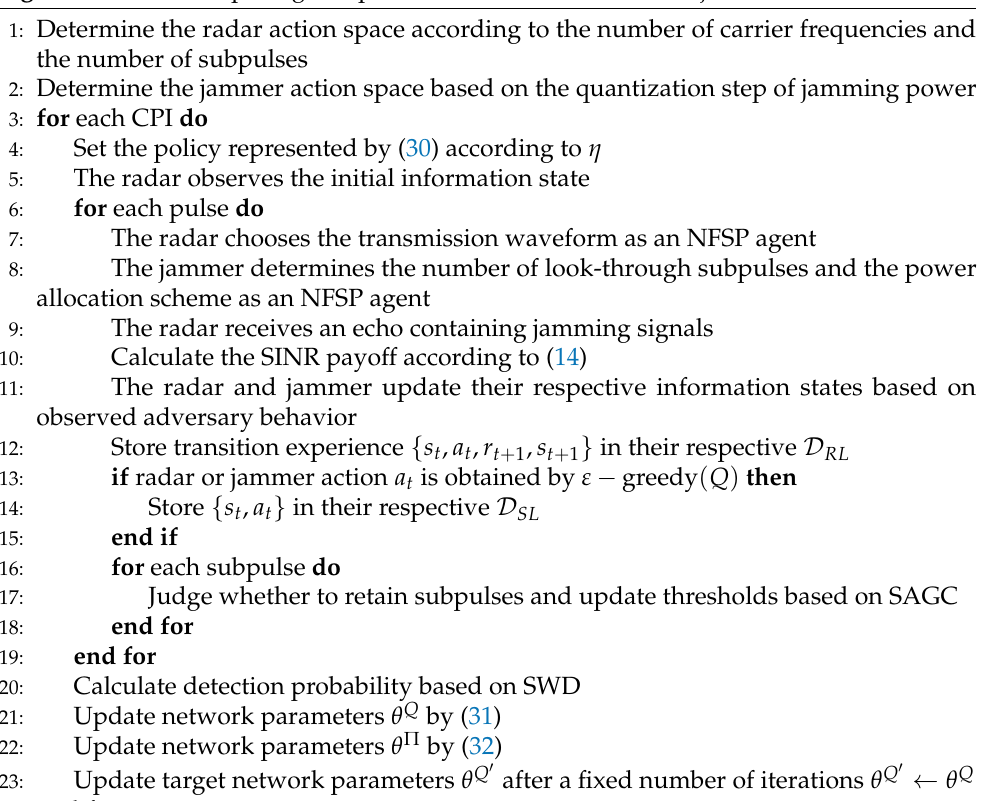
Algorithm 1 The complete game process between the radar and jammer.